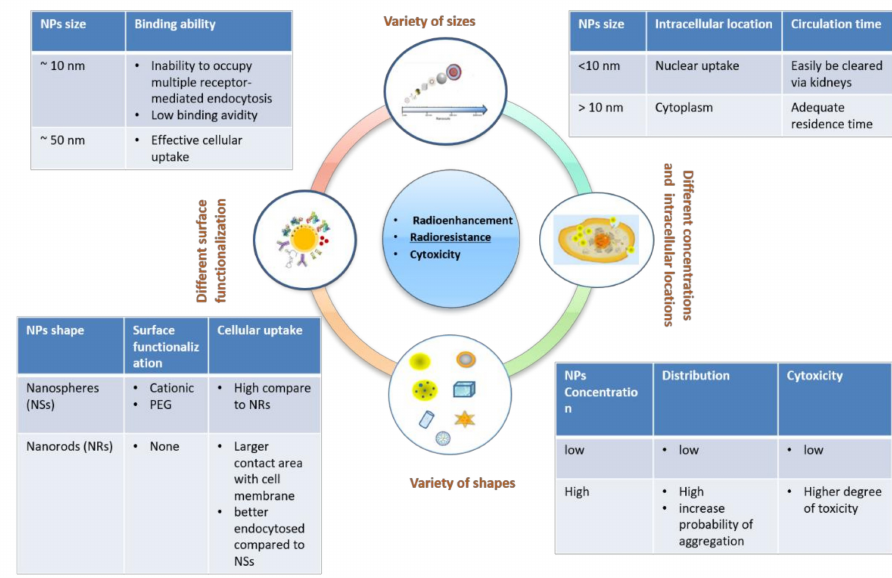
Figure 2. Key parameters for designing an effective NP-based radiosensitizing effect in RT, and known main mechanisms associated with use of metallic NPs in